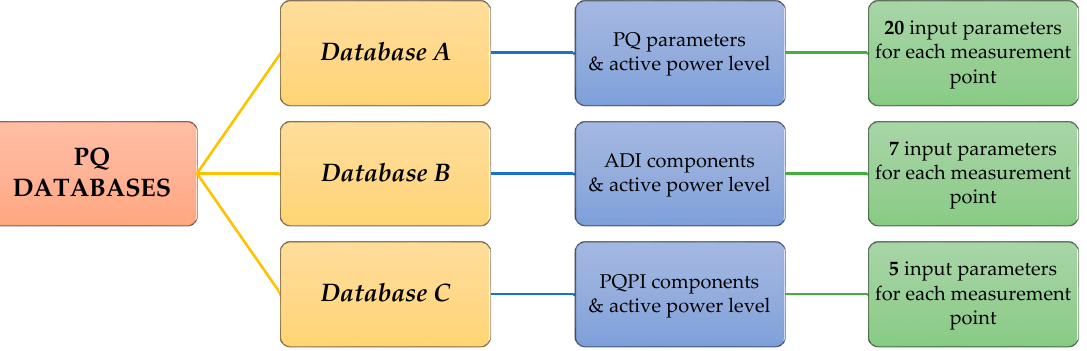
Figure 3. The comparison between investigated databases for hierarchical clustering.